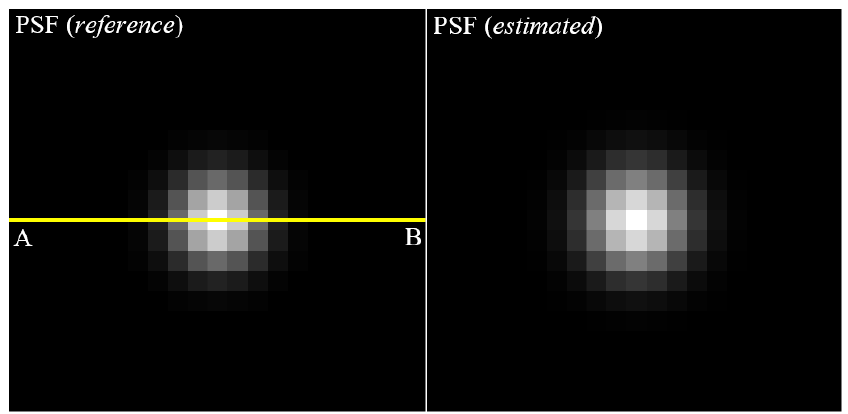
Figure 7. The images of PSF (reference), which is used by convolving the clean image to make the blurred image and PSF (estimated), which was estimated using the proposed algorithm.